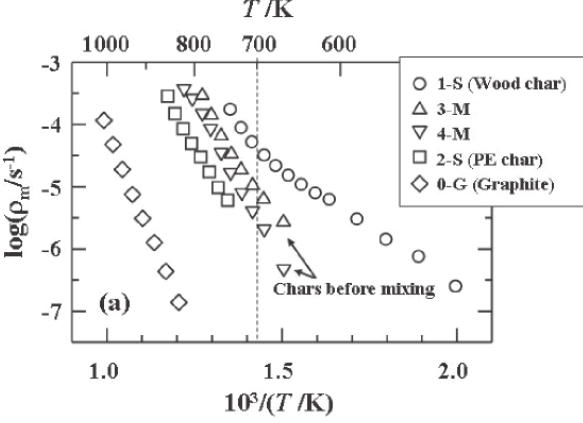
Fig. 6: Variations of apparent rate constant of chars.